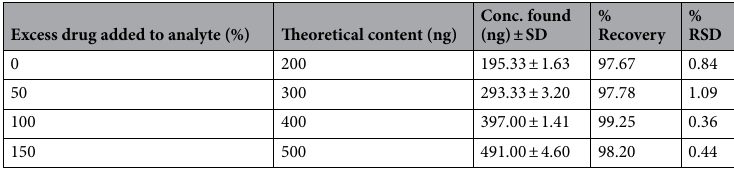
Table 2. Accuracy of the proposed method (n = 6).